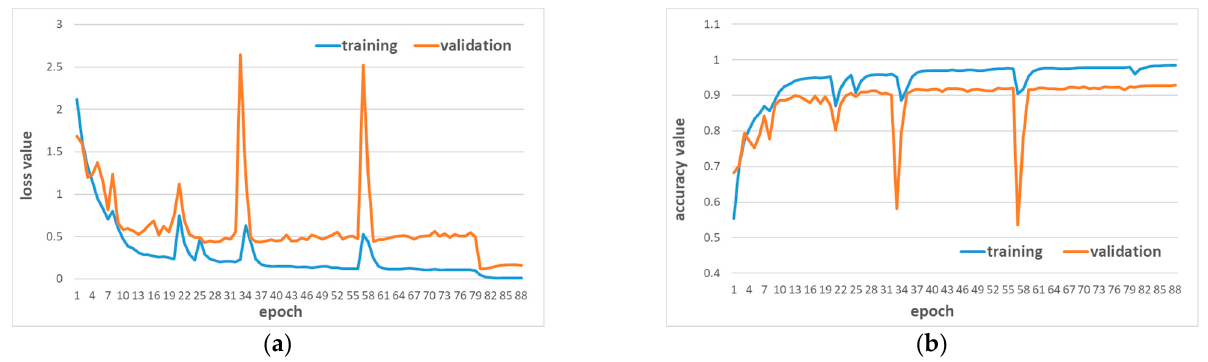
Figure 8. Training process for Hainan dataset A. ( a ) Loss curve. ( b ) Accuracy curve